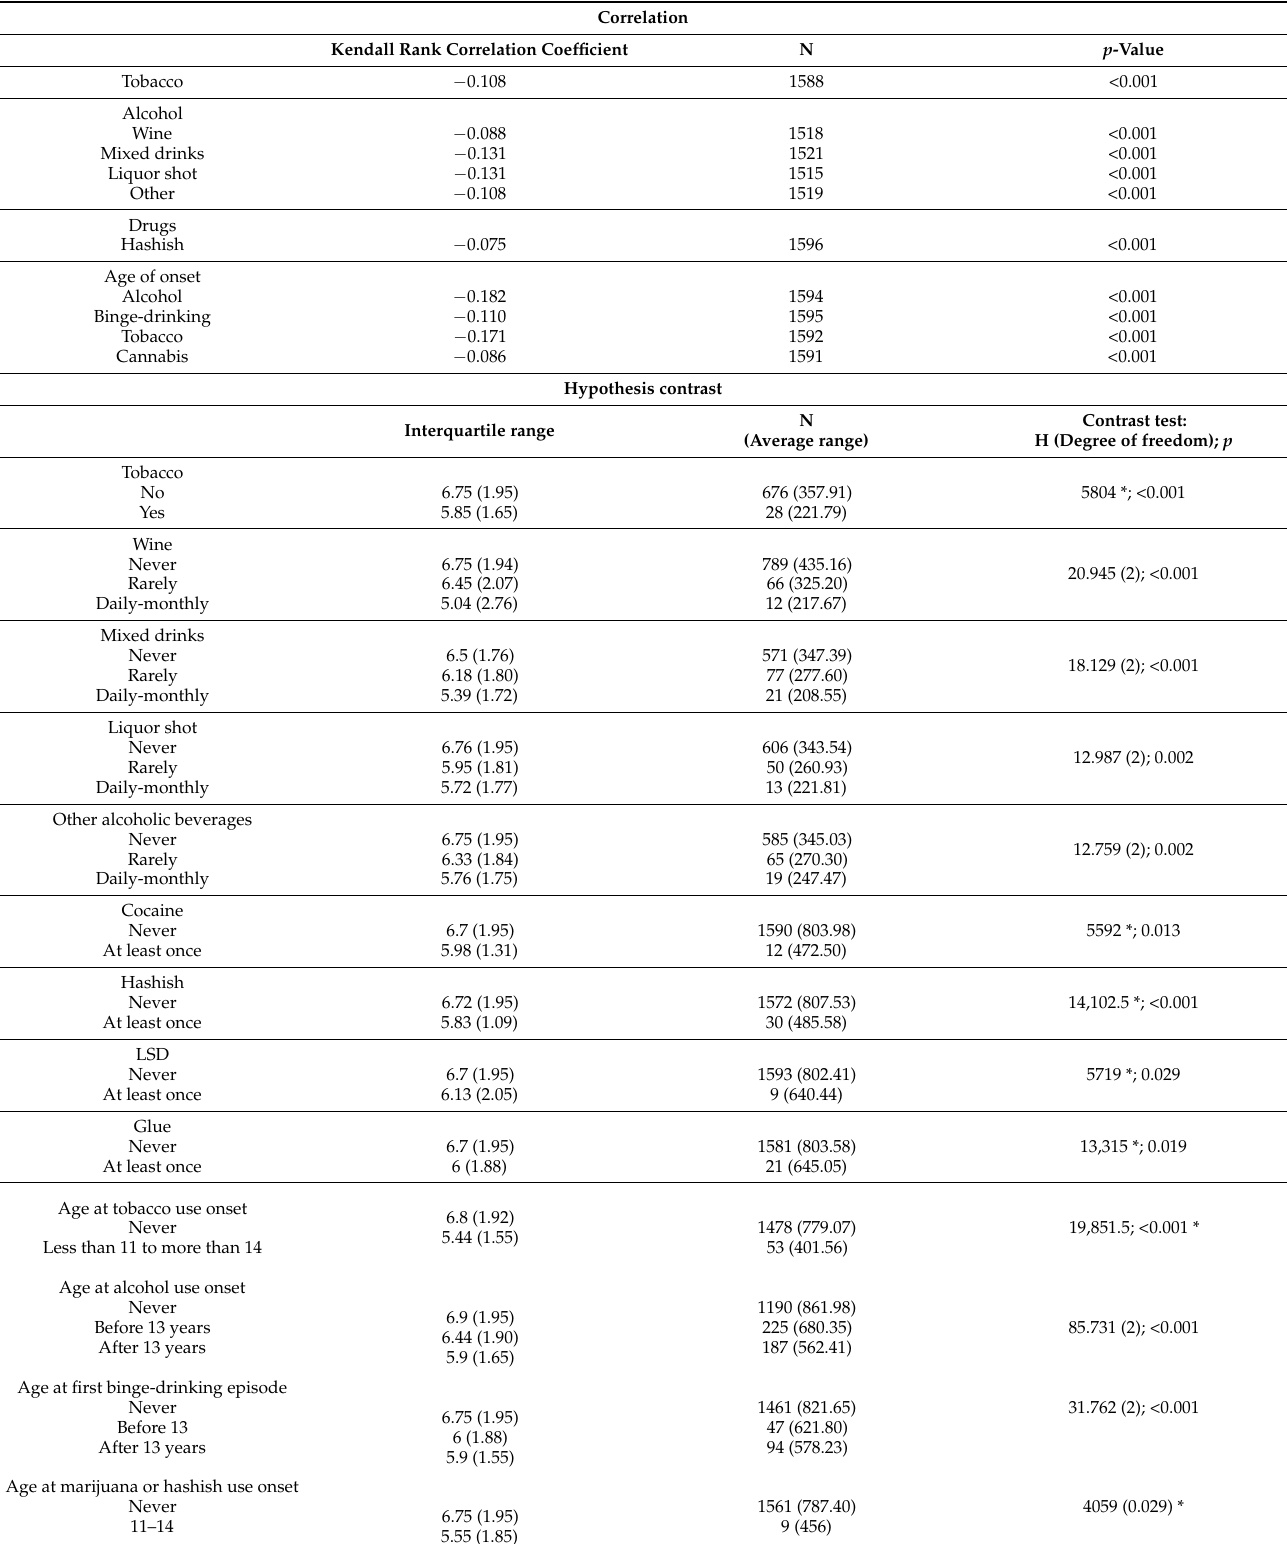
Table 5. Relationship between substance use and academic performance.